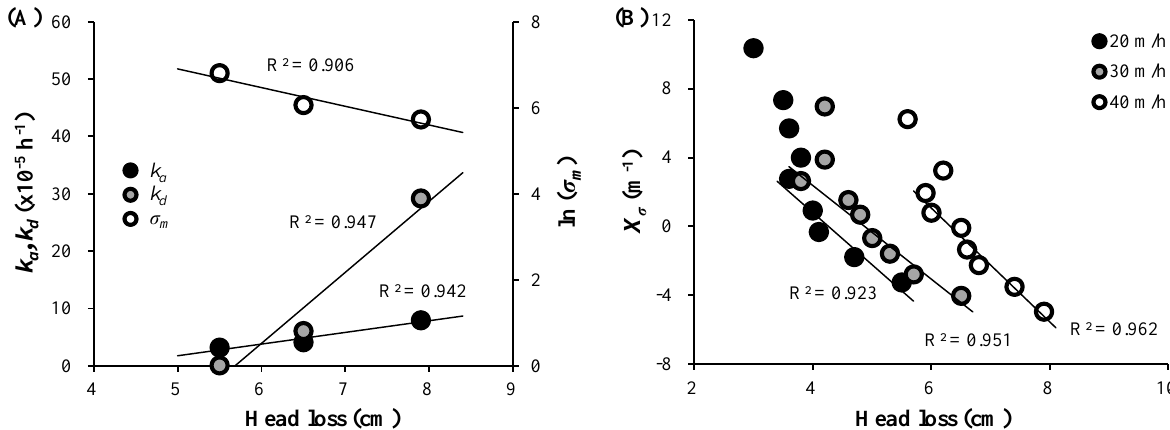
Figure 7. The correlations between the head loss and ( A ) the parameters k a , k d , and ln ( σ m ); and ( B ) X σ .